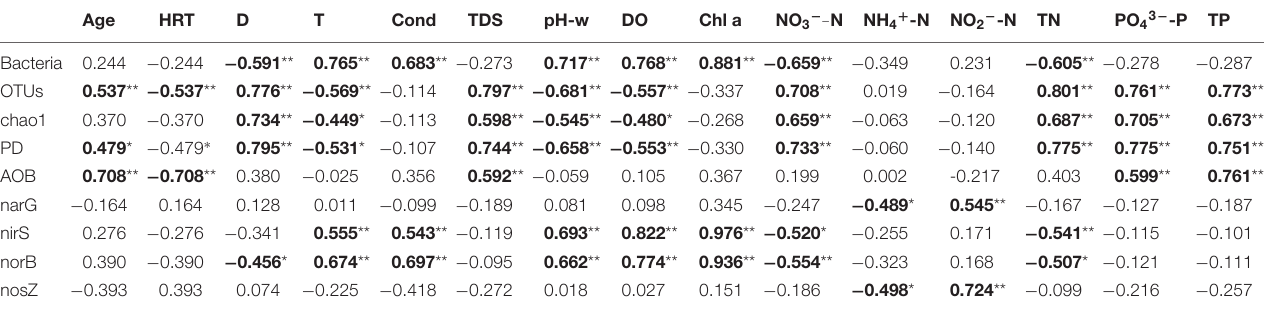
( Figure 3C ). The eigenvalues of the first two principal components closely approached 73.7%. The cumulative contribution ratios of RDA 1 and RDA 2 were 47.5 and 26.2%, respectively. The results indicated that TN ( p < 0.01), NO 2 − -N ( p < 0.05) were significantly positively correlated with the variations in bacterial communities in water. Overall, nutrient nitrogen was a crucial driver in the water bacterial communities. Based on the Pearson correlation analysis, the relationship between environmental parameters and the bacterial community was investigated ( Figure 3D and Supplementary Figure 4